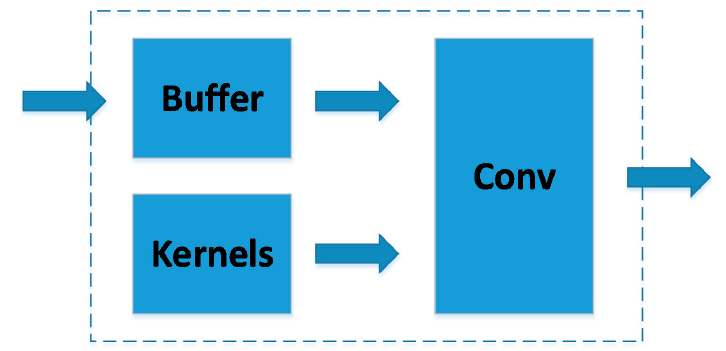
Figure 3. Schematic representation of the ConvNxN architecture.